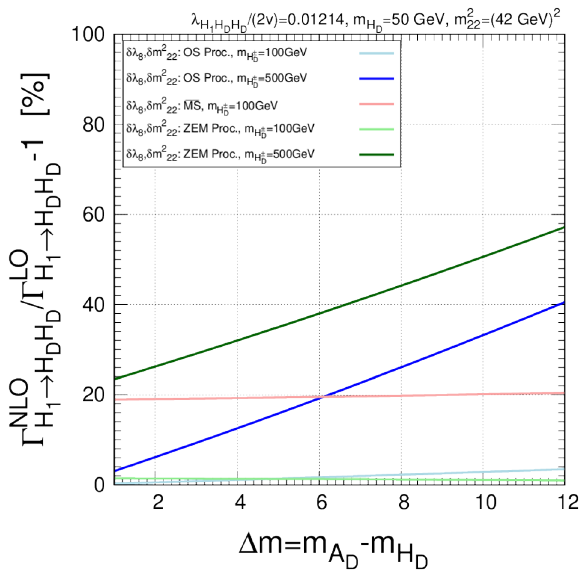
Figure 2 . Relative size of the NLO corrections for H 1 → H D H D as a function of the mass difference between H and A , denoted by ∆ m = m , and for two different values of m , D D A D − m H D H ± D = 100 and 500 GeV. The parameters are chosen as m = 50 GeV and m 2 = (42 GeV) 2 while m H D 22 H ± D the mass of the CP-odd scalar m is scanned keeping m . The other input parameters A D H D < m A D are fixed as in eqs. (5.1), (5.2) and (5.3). The line colours for the different schemes are explained in the